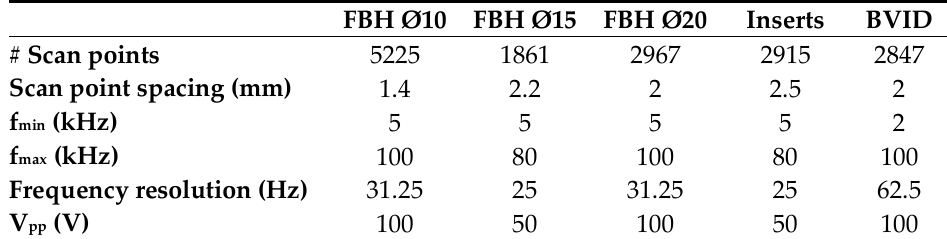
Table 1. LDV measurement